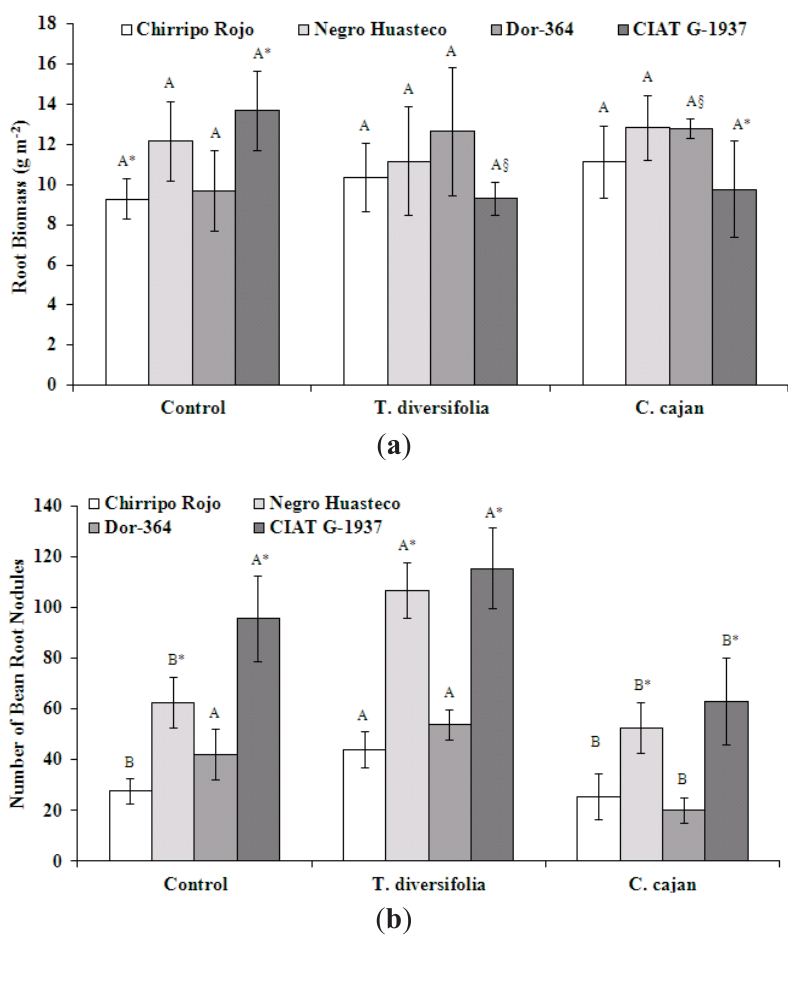
Figure 3. ( a ) Root biomass (g m (cid:237) 2 ) of four different bean genotypes at the flowering phase grown in treatments with no mulch or mulch from T. diversifolia or C. cajan on a Costa Rican Andosol. Different upper case letters above standard error bars indicate significant differences at p < 0.05 in the comparison of mulch treatments within the same genotype [ C. cajan (within Dor-364) and T. diversifolia (within CIAT G-1937) were significantly different from the control only]. Values followed by *, comparing differences between bean genotypes and within mulch treatments, are significantly different at p < 0.05; ( b ) Number of root nodules of four different bean genotypes at the flowering phase grown in treatments with no mulch or mulch from T. diversifolia or C. cajan on a Costa Rican Andosol. Different upper case letters above standard error bars indicate significant differences at p < 0.05 in the comparison of mulch treatments within the same genotype. Values followed by *, comparing differences between bean genotypes and within mulch treatments, are significantly different at p <